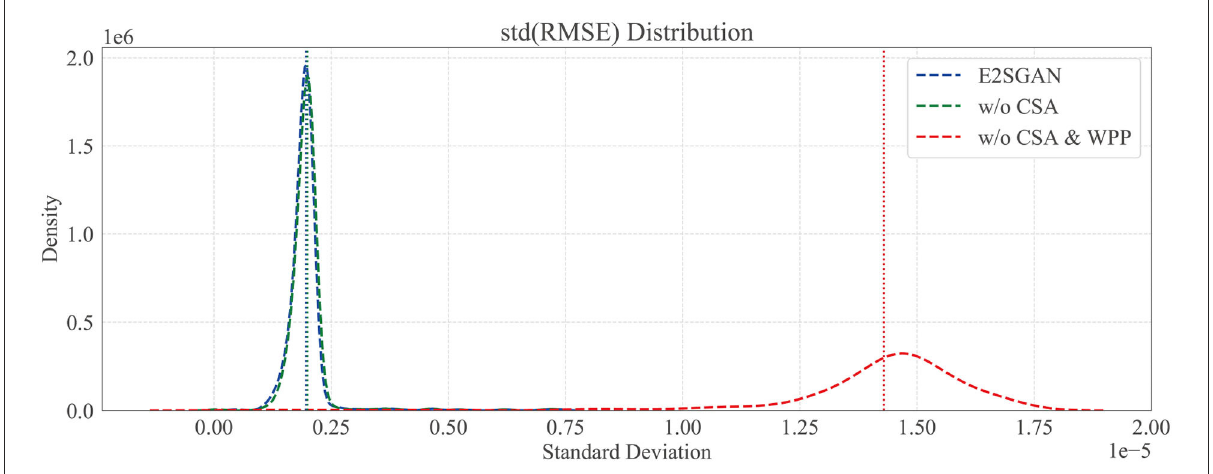
FIGURE5 Temporal robustness study by comparing the standard deviation (SD) distribution of RMSE. Dotted vertical lines are the means of SD.